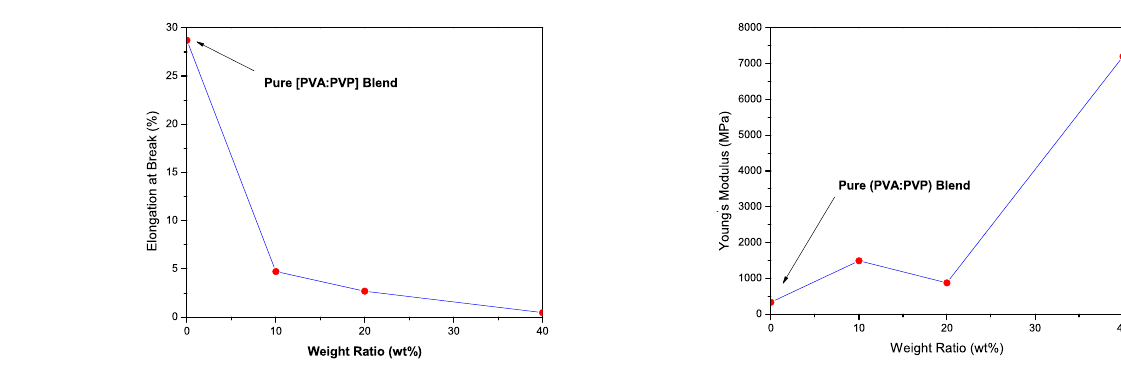
Figure 7: Elongation at break of pure and PVA:PVP polymer blend films reinforced with different weight ra- tios of CdCl 2 · H 2 O salt.